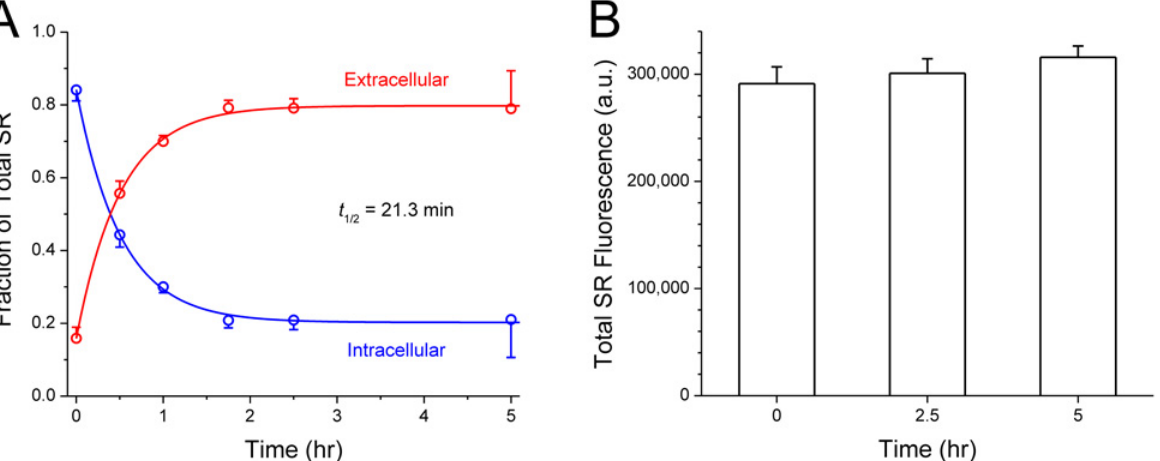
Fig 3. Intracelluar retention of sulforhodamine (SR) tracer after fluid-phase endocytosis. A. Dishes of CV1 cells were incubated with 300 μ M SR and empty DSPC:PS liposomes for 1 hr to promote fluid-phase endocytosis, and then maintained in HBSS. The proportion of intracellular and extracellular SR was assayed at various times (see Methods for details). The majority (80%) of endocytosed SR reappeared in the extracellular medium with a half-life of ± 1.0 min, while 20% was retained more stably. Solid curves are least-squares single-exponential fits to the data, with exponential time constant t 1/2 = 21.3 τ × ln2 = 0.693 (cid:1) τ ). Each data point is the average of 3 replicates. B. CV1 cells endocytosed SR as above. At 3 time points thereafter, τ = 30.8 ± 1.5 min ( t 1/2 = cells in each dish were lysed and the total amount of SR was assayed by fluorescence spectroscopy. The total SR fluorescence recovered did not differ significantly between time points; each time point is the average of 3 replicates. The means are not significantly different (one-way ANOVA, p = 0.159).